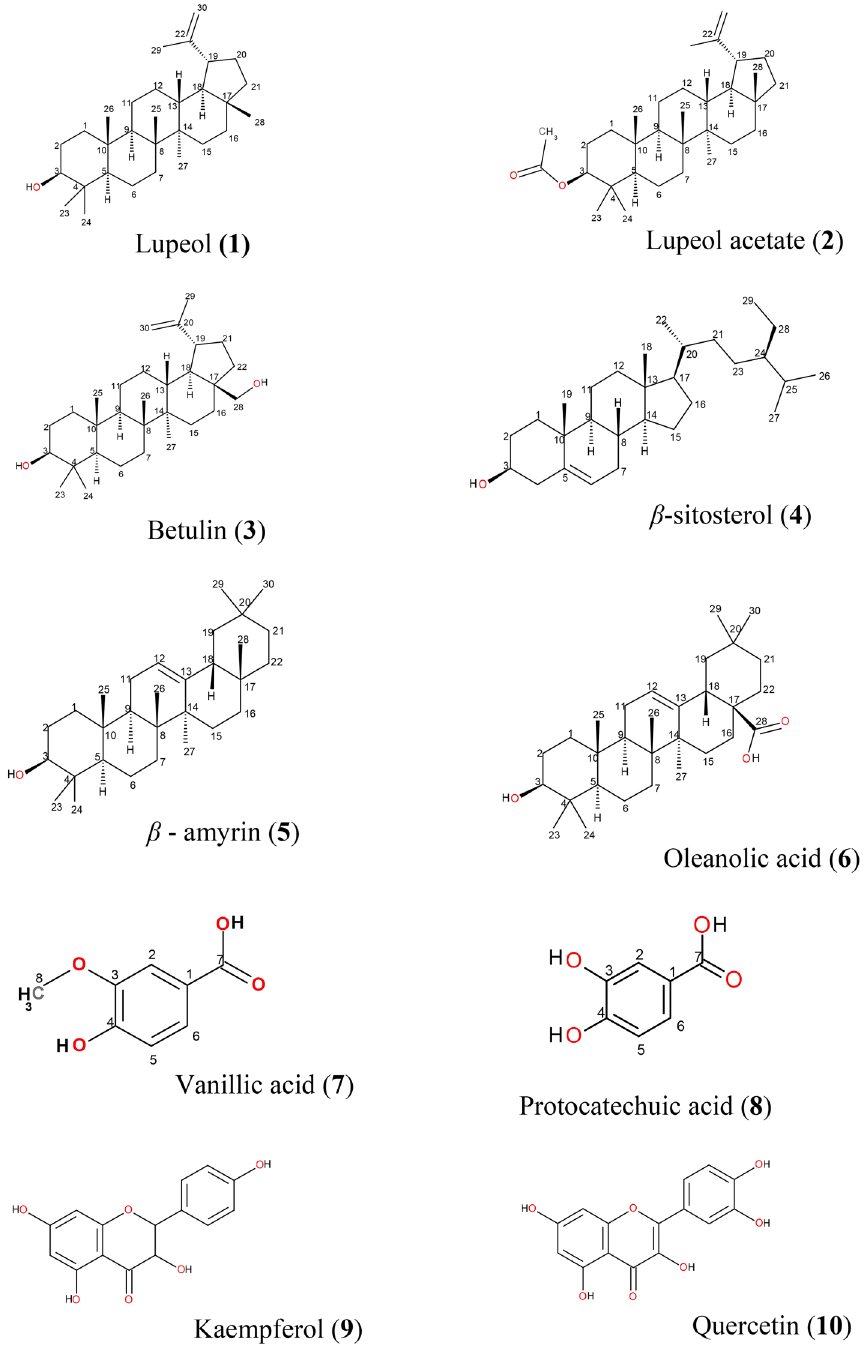
Figure 2. Structures of compounds isolated from n- hexane ( 1 and 2 ), chloroform ( 3–6 ) and ethyl acetate ( 7–10 ) fraction of methanolic extract of Monotheca buxifolia